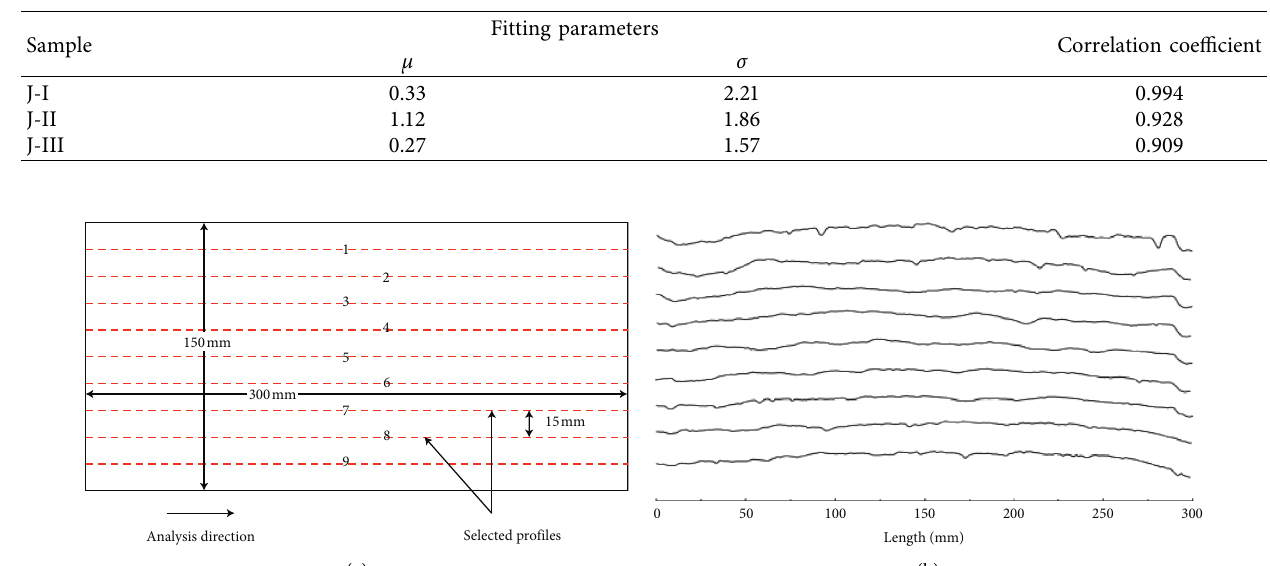
Table 1: Parameters for Gaussian distribution obtained by equation (1).